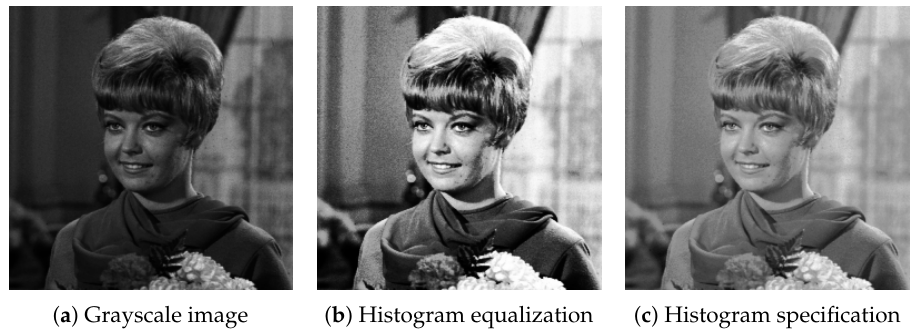
Figure 3. Histogram manipulation: the contrast of an input grayscale image ( a ), which is an image in the SIDBA [16] image dataset, is enhanced by histogram equalization ( b ) and RGB color cube-based histogram specification ( c